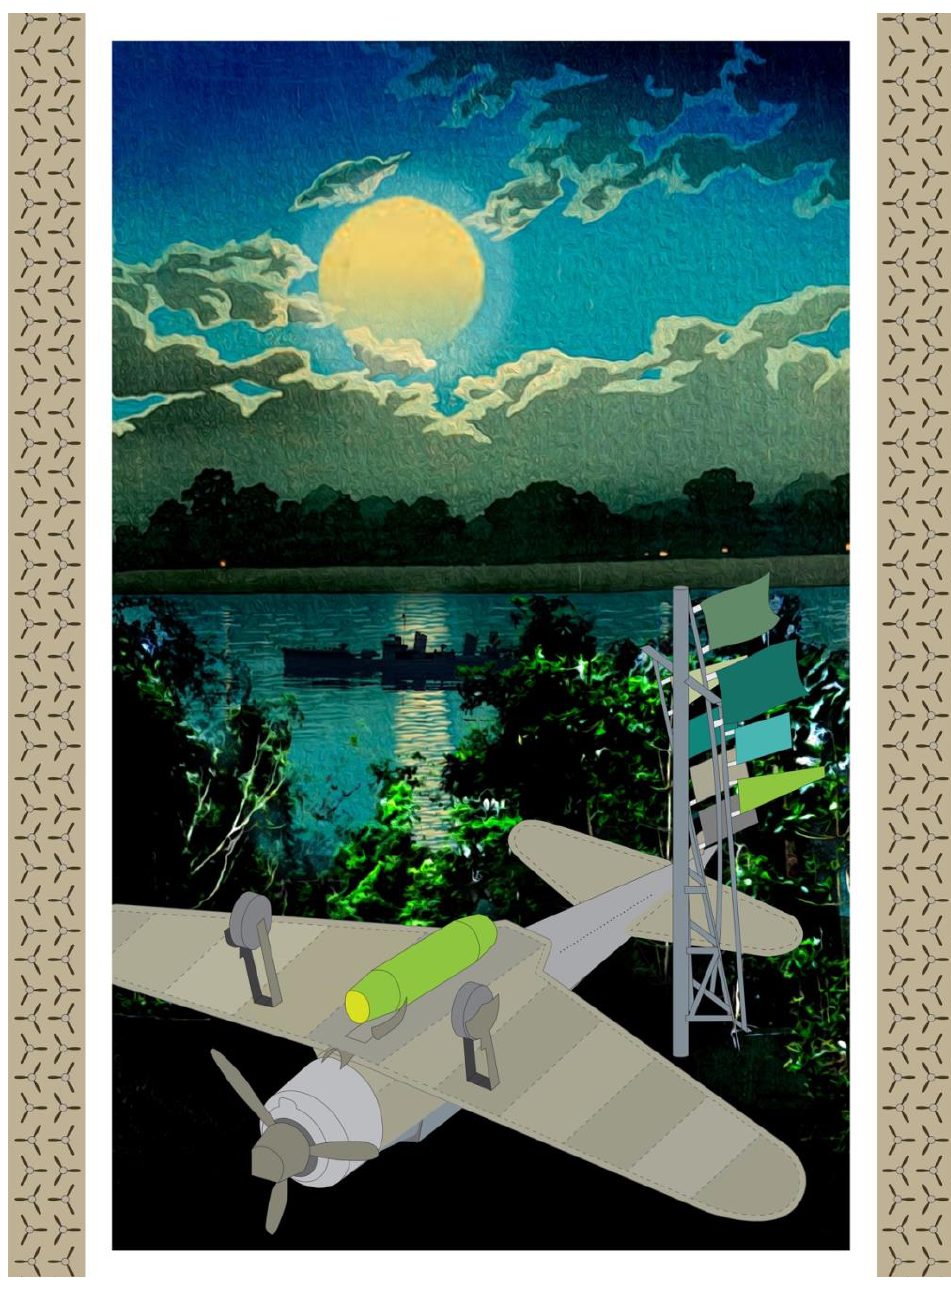
Kio Griffith, Eight Views of the Sun Setting on the South Pacific / Bougainville , 2021. Digital collage print on